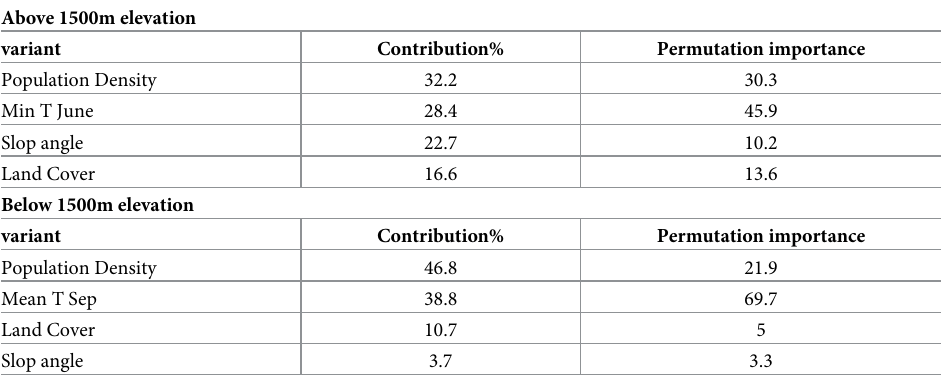
Table 2. Estimates of relative contributions of the predictor